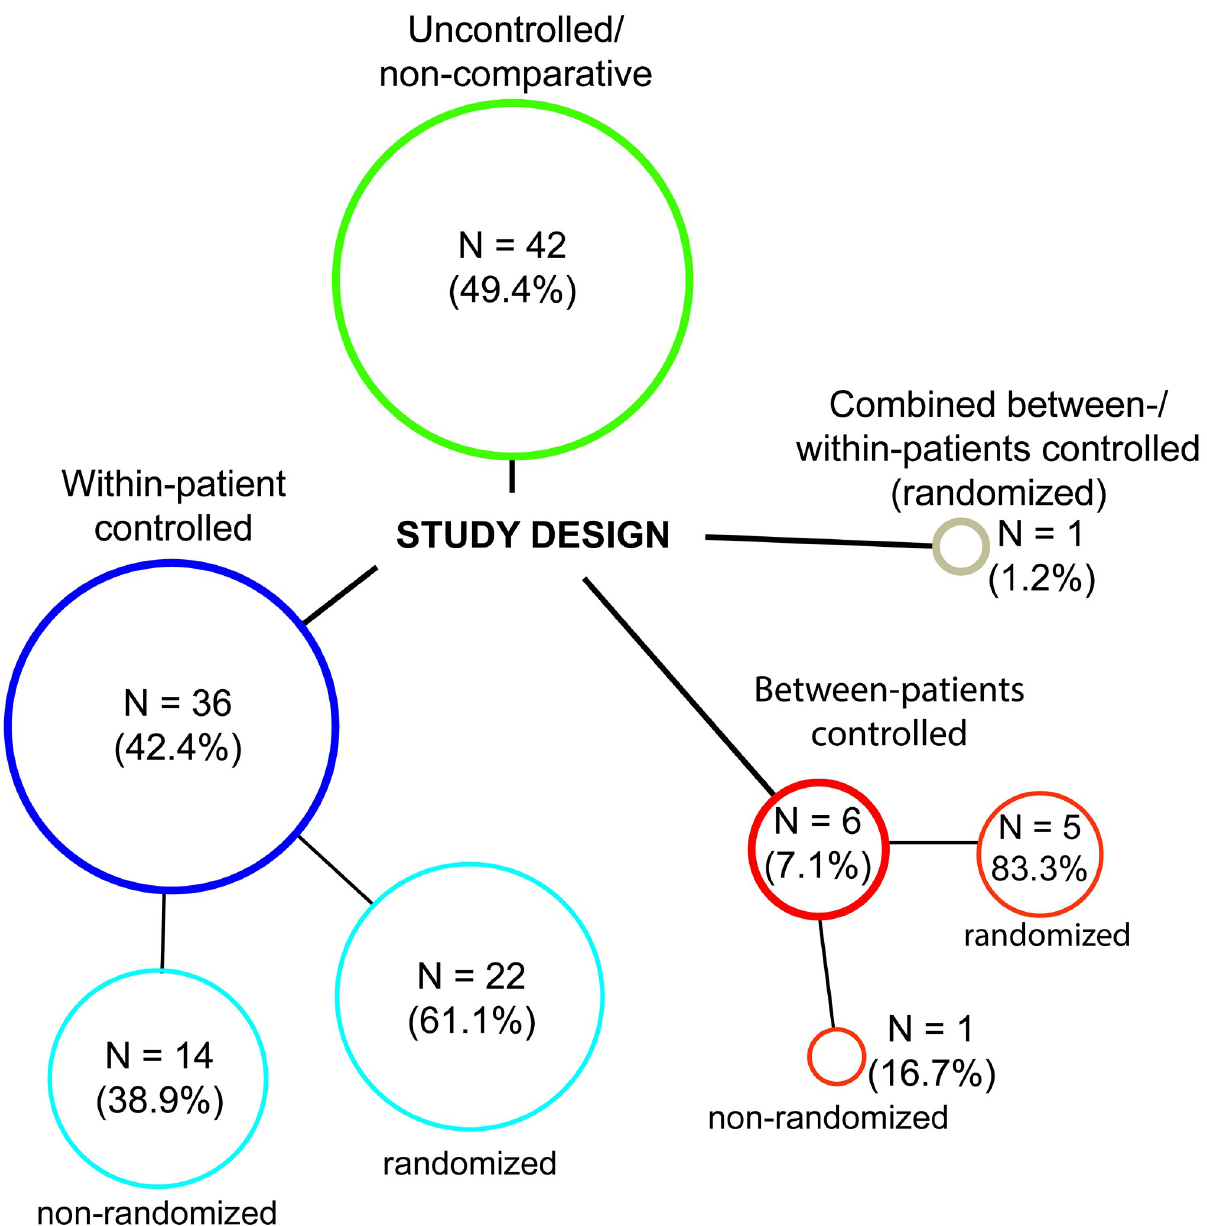
Fig 2. Stratification of the study designs used in the included studies. Studies with a control group (controlled studies) allocated different treatments to different treatment sites within individual patients (within-patient controlled) or to different patients (between-patients controlled).